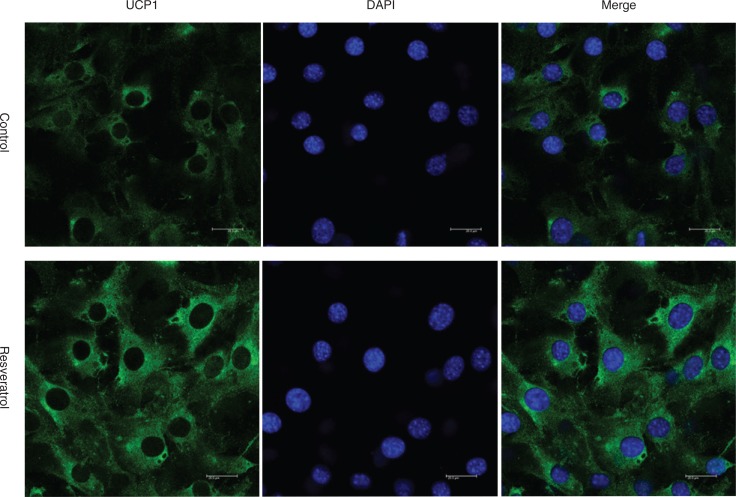
The effect of resveratrol treatment on uncoupling protein 1 (UCP1) protein expression. 3T3-L1 adipocytes with 20 μM Res treatment for 6 days were used to stain for UCP1, which were captured at 400× magnifications. The amount of DMSO was 0.08% in control.